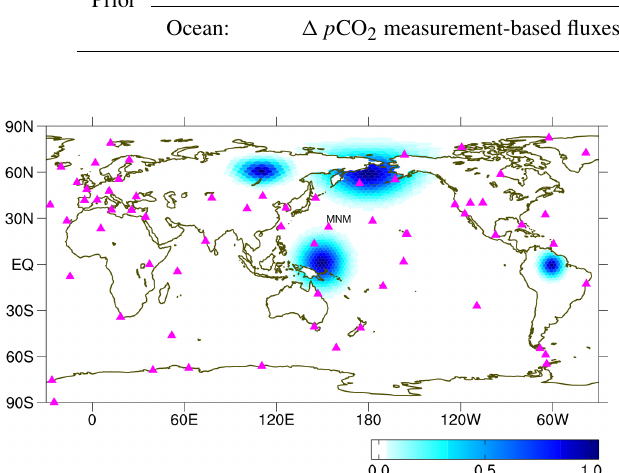
Figure 2. Locations of surface flask observation site (magenta tri- angle) and four distributions of error correlation introduced in the off-diagonal elements of B , which are centered at two land grids (60 ◦ N, 110 ◦ E and 60 ◦ N, 180 ◦ ), and two ocean grids (0 ◦ , 150 ◦ E and 0 ◦ , 60 ◦ W) selected for